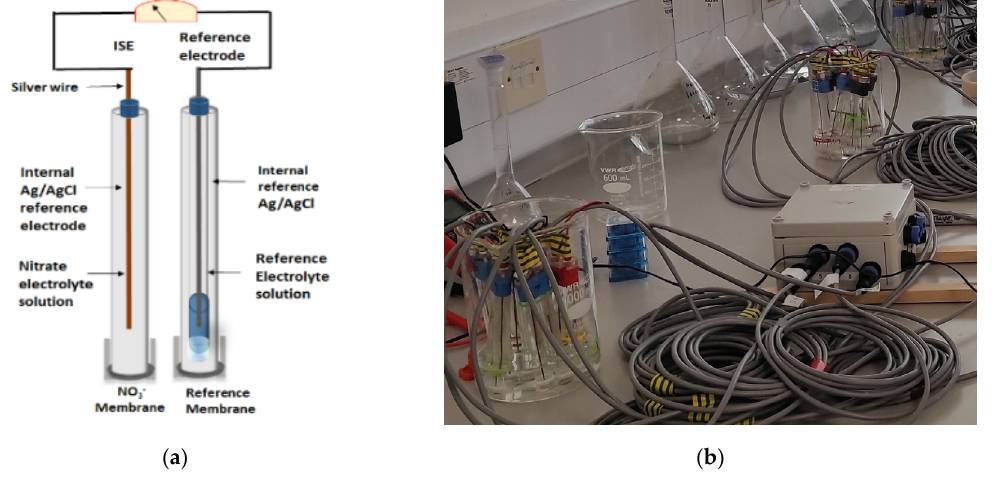
Figure 1. Ion-selective electrodes for nitrate sensing: ( a ) schematic representation of an ion-selective electrode; ( b ) prototype nitrate sensors connected to an IoT sensor node.